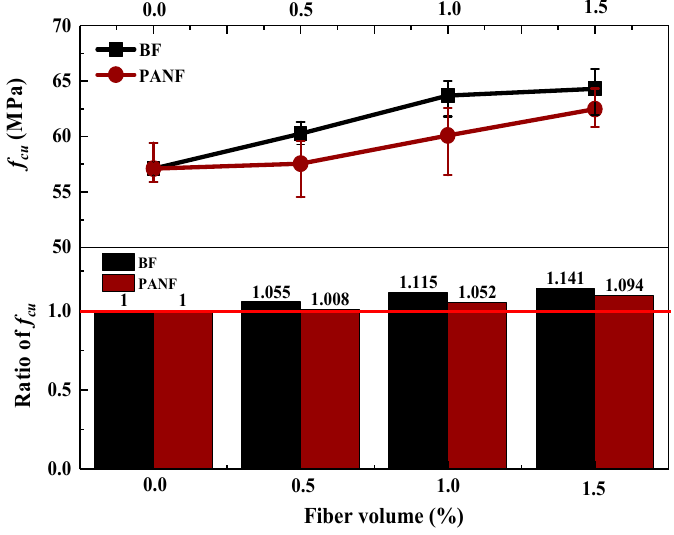
Figure 6. E ff ect of fibers on cube compressive strength of Figure 6. Effect of fibers on cube compressive strength of LWACs.